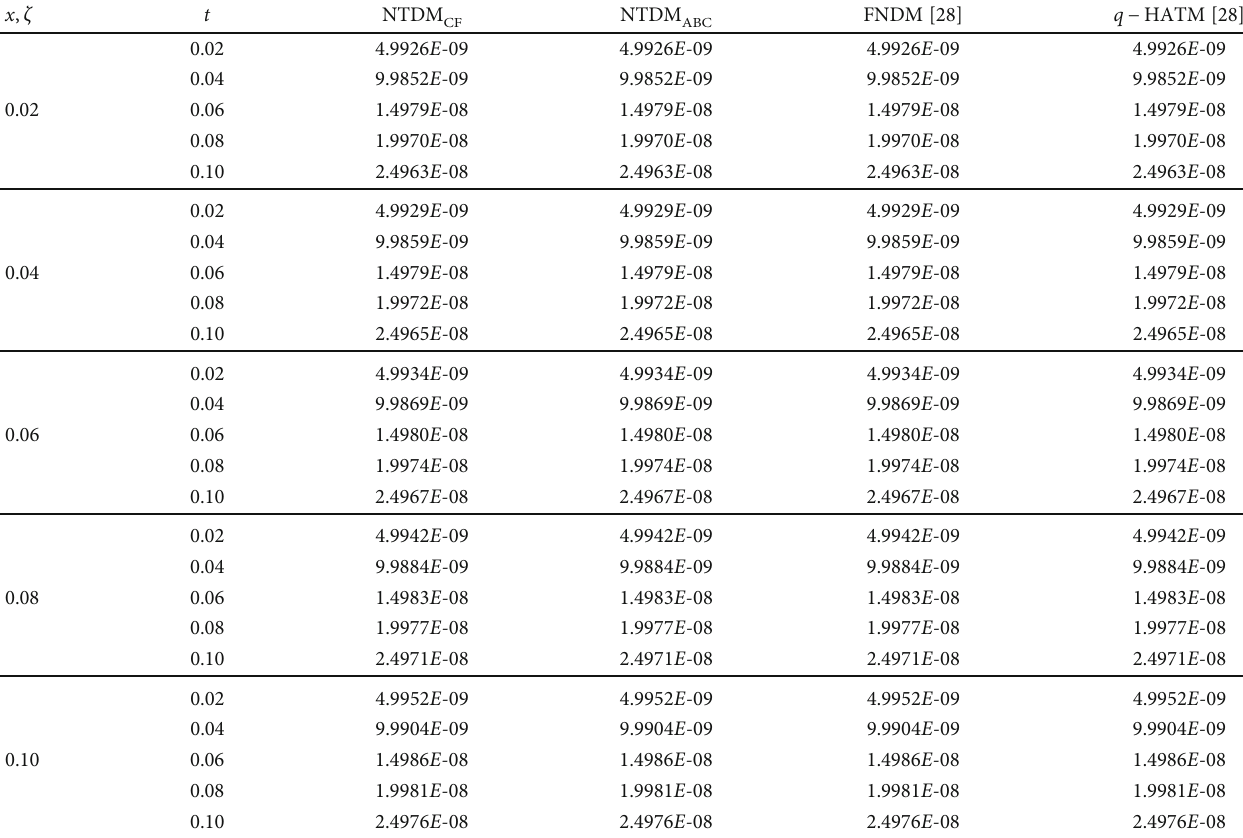
Table 3: Absolute errors of NTDM